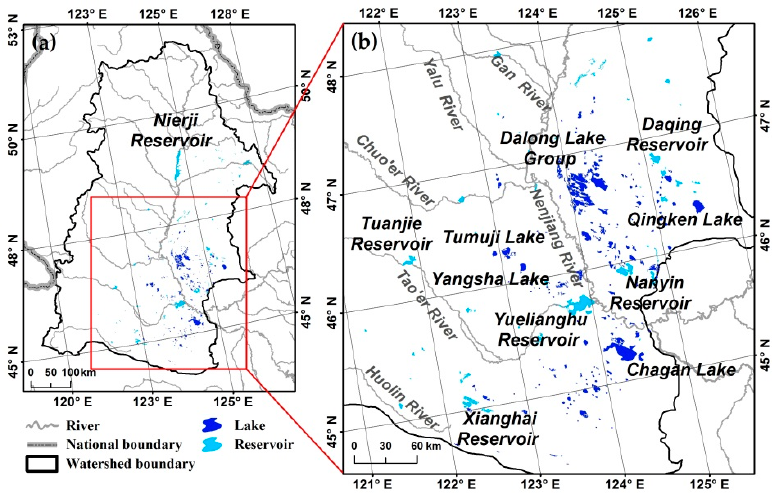
Figure 4. Spatial distribution of lakes and reservoirs in the Nenjiang watershed (NJW) in 2015.